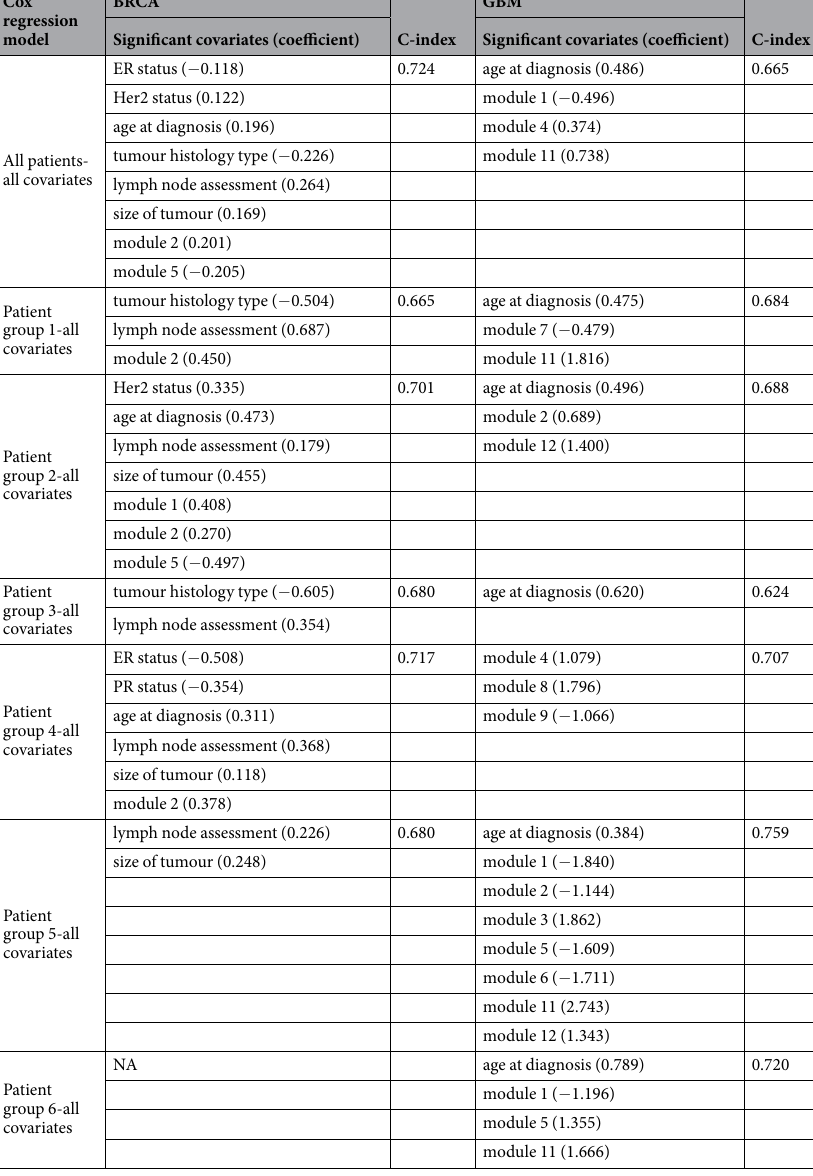
Table 3. The Cox regression models trained for BRCA and GBM for all patients and for each specific patient group, with different combinations of covariates. Significant covariates and C-index are listed for each